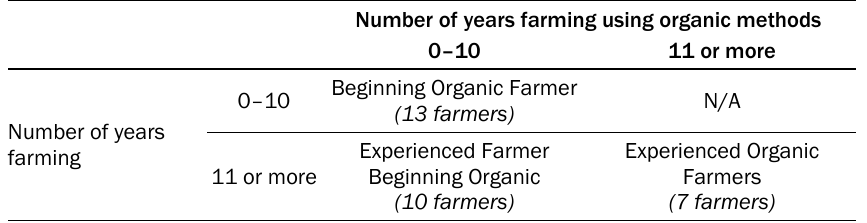
Table 2. Farmer Categories and Sample Size